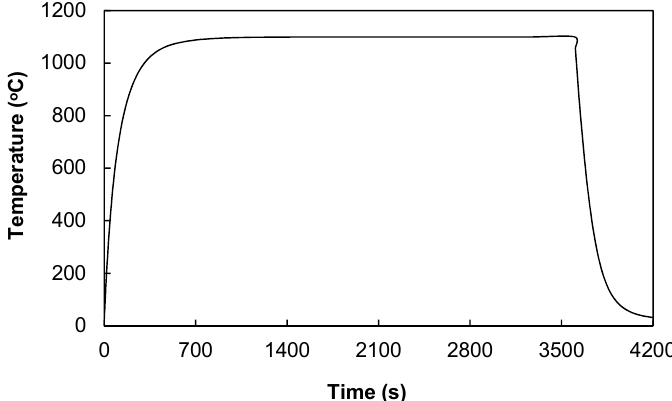
Figure 10. Temperature evolution in the coating.